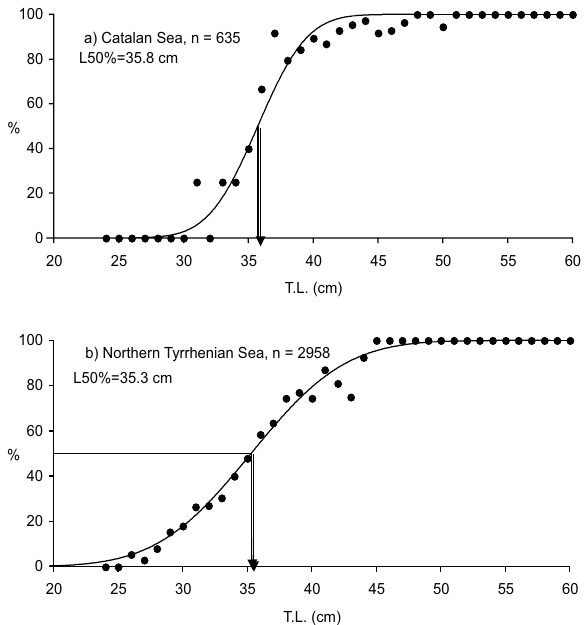
Fig . 9. – Females length at first maturity (50%) in a) Catalan Sea and b) northern Tyrrhenian